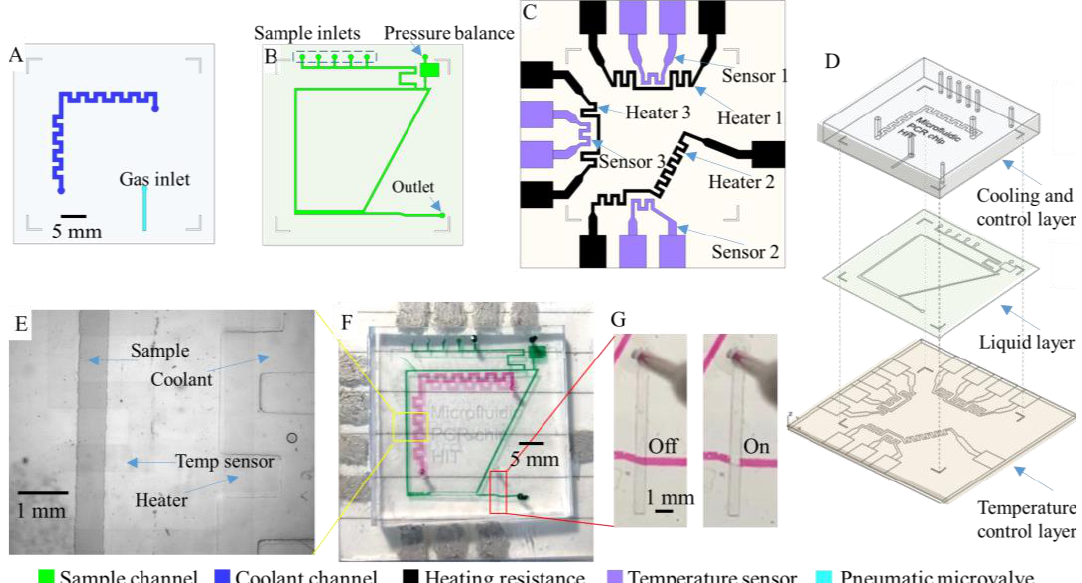
Figure 2. Microfluidic chip with three layers. ( A ) Design of cooling and control layer; ( B ) design of liquid reaction layer; ( C ) design of ITO temperature control layer; ( D ) relative location of 3 layers; ( E ) micrograph of transparent components; ( F ) assembled chip; ( G ) on – chip valve.